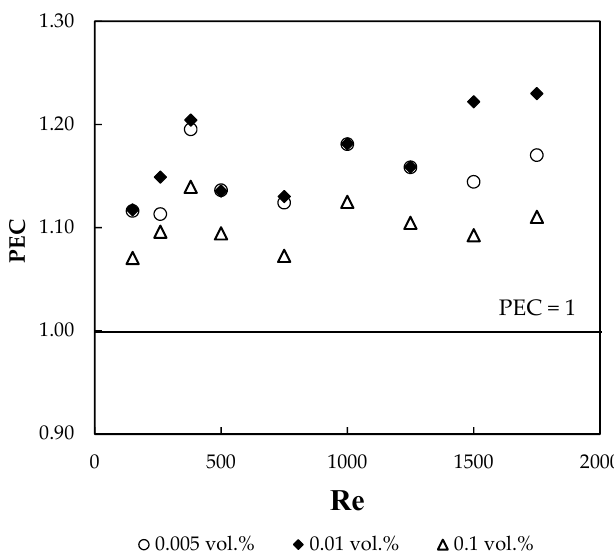
Figure10. Figure 10. The PEC value of nanofluids versus Reynold’s number at various nanoparticle concentrations.